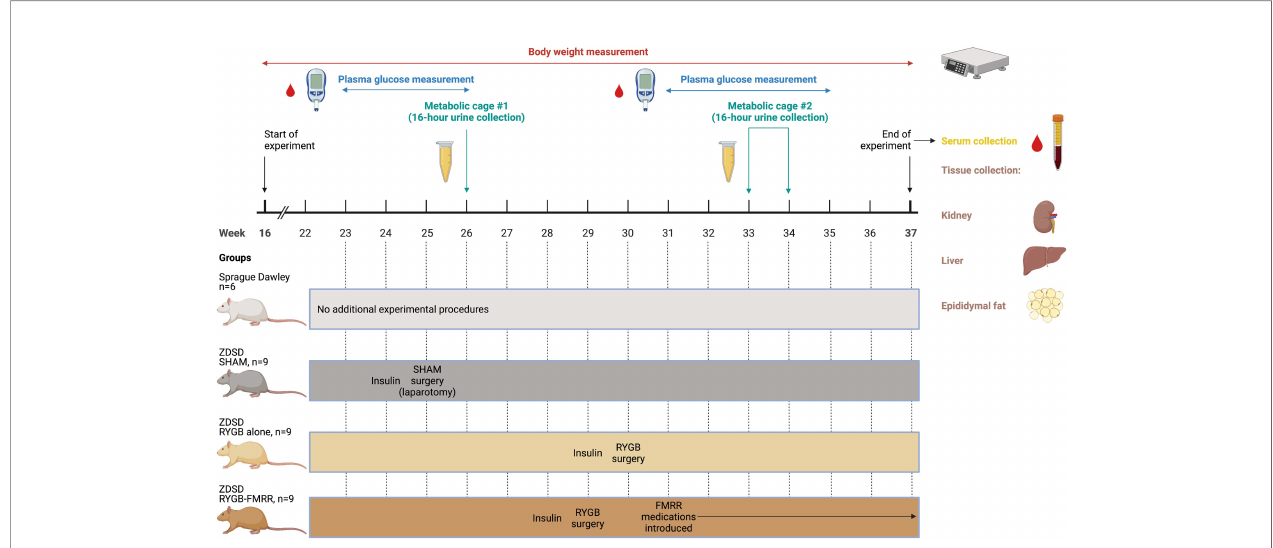
FIGURE 1 | Overview of the study design. Created with BioRender.com. In the SHAM, RYGB, and RYGB-FMRR groups, glycaemic control was optimized for one week prior to surgery with daily subcutaneous injection of insulin degludec (Tresiba ® , Novo Nordisk) to achieve a fasting plasma glucose below 12 mmol/L. When introducing medications in the RYGB-FMRR group, metformin monotherapy was introduced for the fi rst two days to monitor for adverse responses, including anorexia. The remaining medications (feno fi brate, ramipril, and rosuvastatin) were commenced thereafter when no adverse response was observed. FMRR, feno fi brate, metformin, ramipril, and rosuvastatin; RYGB, Roux-en-Y gastric bypass; RYGB-FMRR, Roux-en-Y gastric bypass plus feno fi brate, metformin, ramipril, and rosuvastatin; SHAM, sham surgery (laparotomy); ZDSD, Zucker Diabetic Sprague